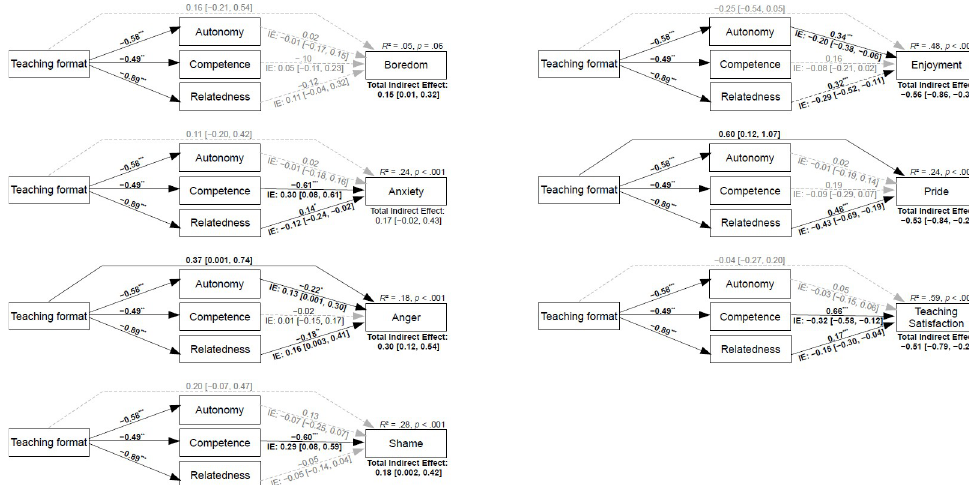
Fig 2. Mediation analyses results. Mediation analyses depict unstandardized coefficients, which indicate differences in the mediator variables that are due to the teaching format (emergency online vs. face-to-face) and differences in the criterion variable that are due to differences in the mediator variable. Negative values from teaching format to need satisfaction indicate lower values in the emergency online teaching sample. IE = Indirect effect of teaching mode through the basic need on the criterion variable incl. bootstrap confidence interval; for a significant indirect effect, the respective CI does not include 0. Solid black lines depict significant, dashed grey lines non-significant effects. ��� p < .001. �� p < .01. � p <